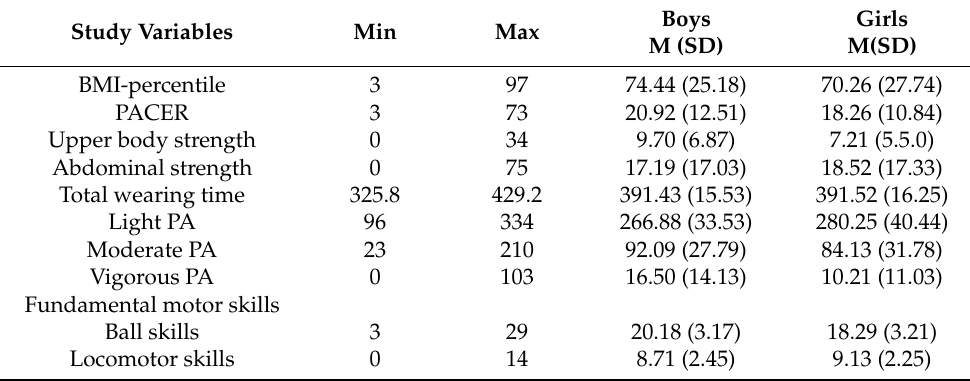
Table 1. Sample Characteristics and Descriptive Statistics (N =